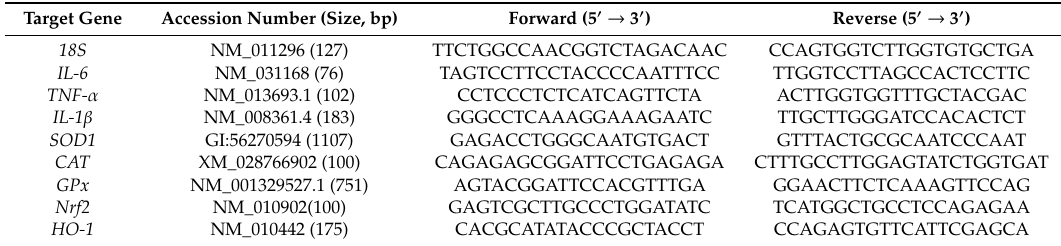
Table 1. Specific primer sequences for